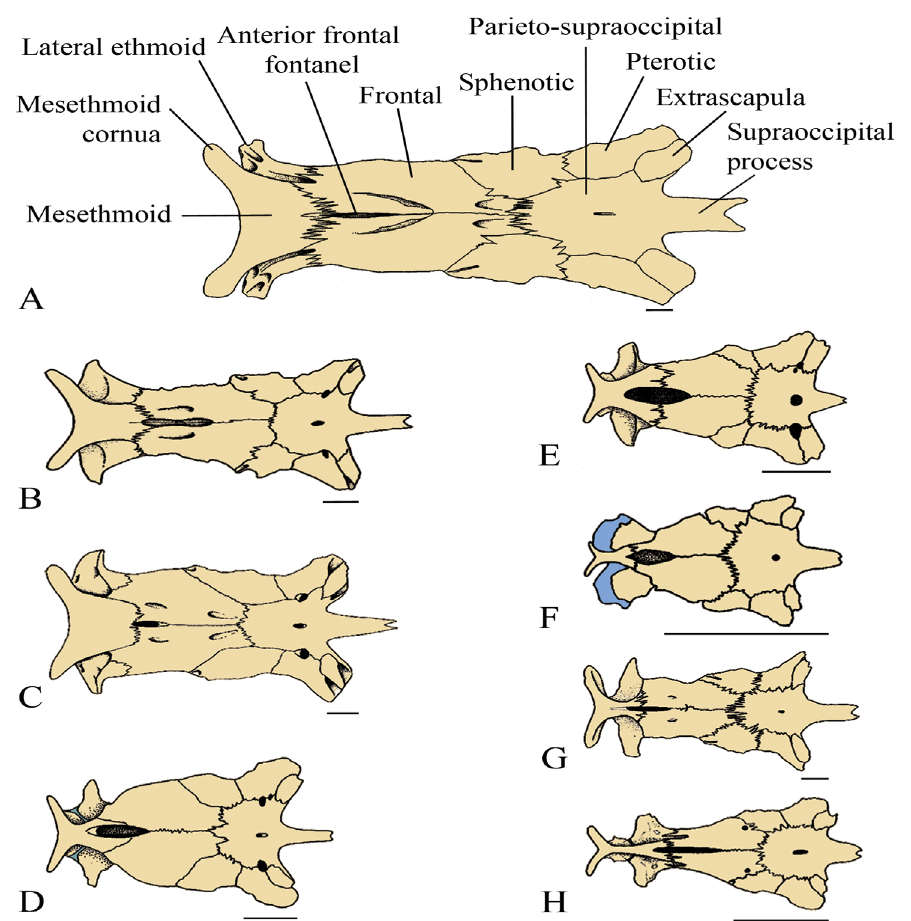
FIGURE 5 | Neurocranium in dorsal view: A. Lophiosilurus alexandri , MZUEL 5542; B. L. fowleri , MZUEL 12095; C. L. apurensis , MBUCV-V-15379; D. L. albomarginatus , ROM 61336; E. Batrochoglanis raninus , MZUSP 23407; F. Microglanis parahybae , MNRJ 15989; G. Pseudopimelodus mangurus , MZUEL 12937; H. Rhyacoglanis paranensis , MZUEL 6034. Bones in yellow and cartilage in bluish grey. Scale bars = 5